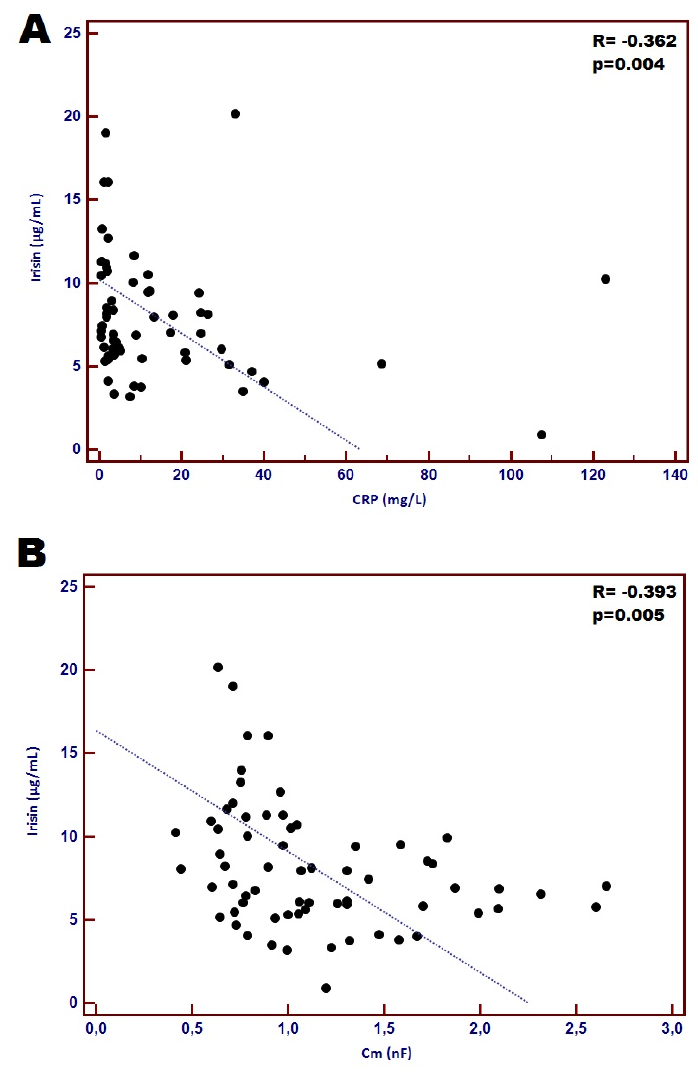
Figure 1. Correlation between concentration of plasma irisin and CRP ( A ) and correlation between plasma irisin and Cm ( B ).